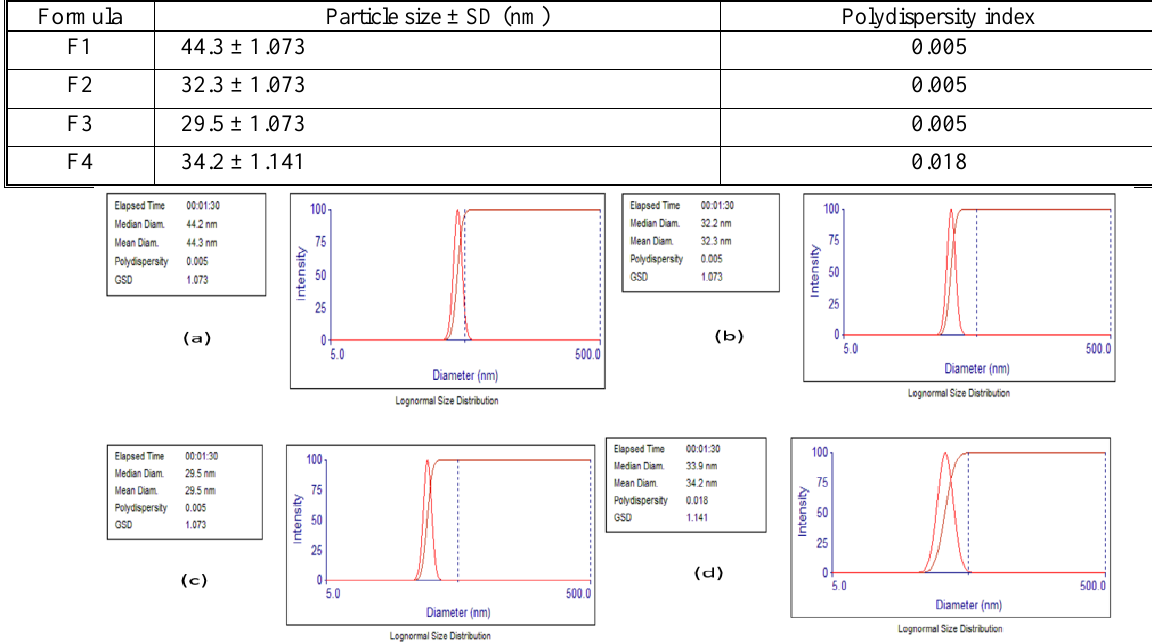
Figure 6. Droplet size and polydispersity index of of tacrolimus liquid self-microemulsifying drug delivery systems (a) F1; (b) F2; (c) F3; (d)